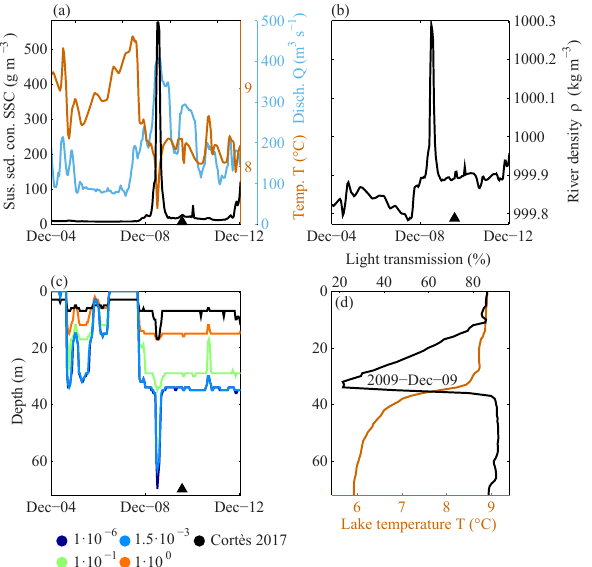
Figure A3. River intrusion entrainment sensitivity analysis for the LB/Aare system in October 2011. (a) SSC (black), temperature ( T ; orange) and river discharge ( Q ; blue) from Aare station no. 2085. (b) River density at station no. 2085 obtained from T and SSC in (a) . (c) River intrusion depth calculated from Appendix A with varying entrainment constant β (Eq. A13); Light green denotes the value used in this study; black indicate intrusion depth modeled as in Cortés et al. (2014). (d) Vertical measurements of T and light transmission in LB for 11 October 2011. The triangles in (a) – (c) mark the time of the vertical profile in (d) .